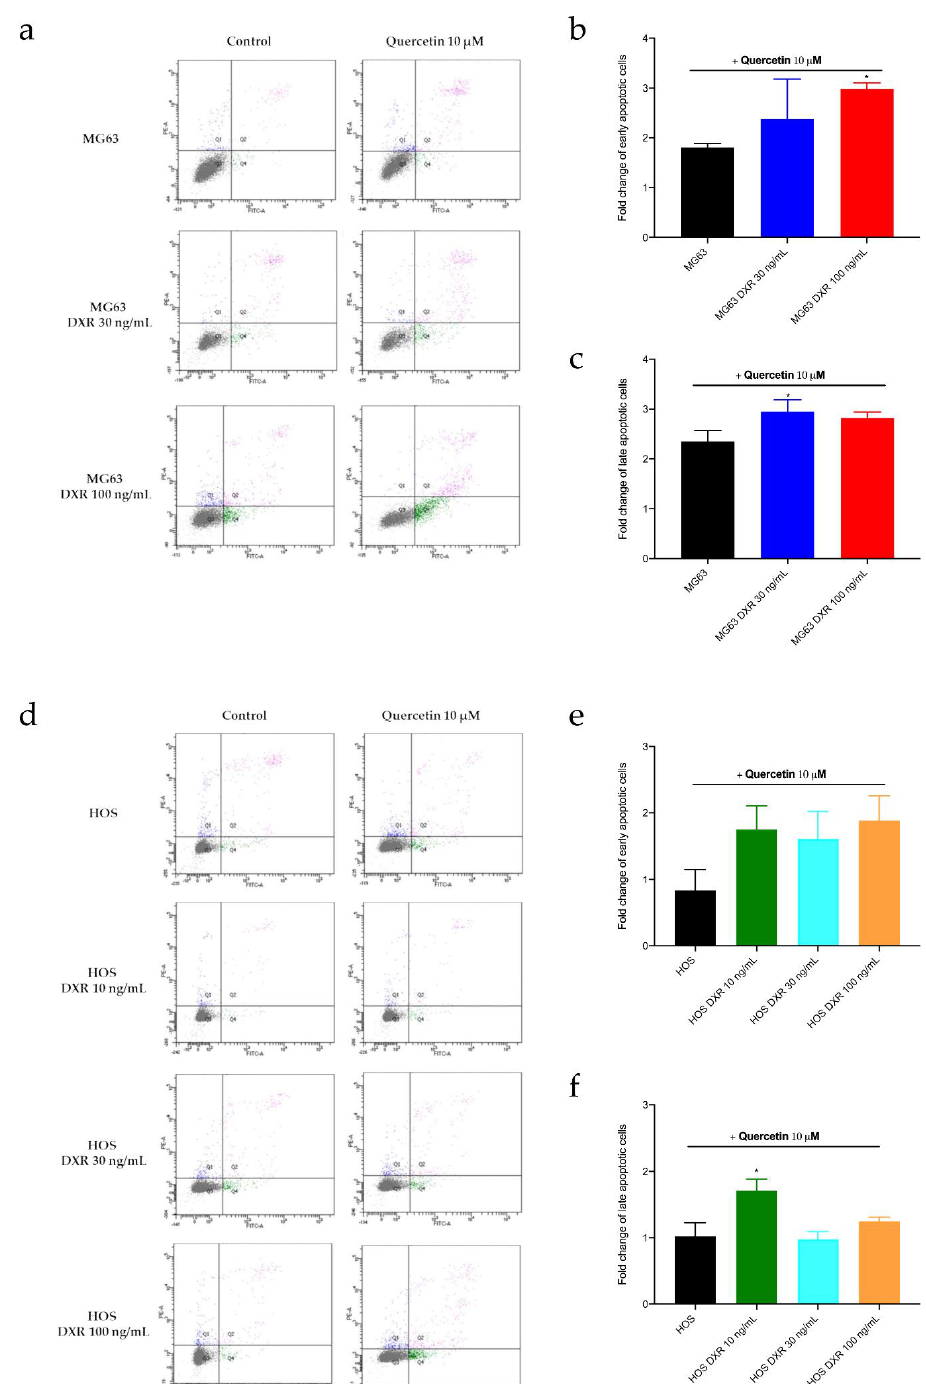
Figure A3. ( a ) Representative cytograms of apoptotic cells analyzed with Annexin V-PI staining. MG63, MG63 DXR 30 ng/mL and MG63 DXR 100 ng/mL cells were treated 72 h with quercetin 10 µ M. The graphs represent the quantification of early ( b ) and late apoptosis ( c ) by showing the ratio between treated and untreated. ( d ) Representative cytograms of apoptotic cells analyzed with Annexin V-PI staining. HOS, HOS DXR 10 ng/mL, HOS DXR 30 ng/mL, and HOS DXR 100 ng/mL late apoptosis ( f ) by showing the ratio between treated and untreated. Data are shown as mean ± SD of three different experiments. * p < 0.05, treated vs. untreated